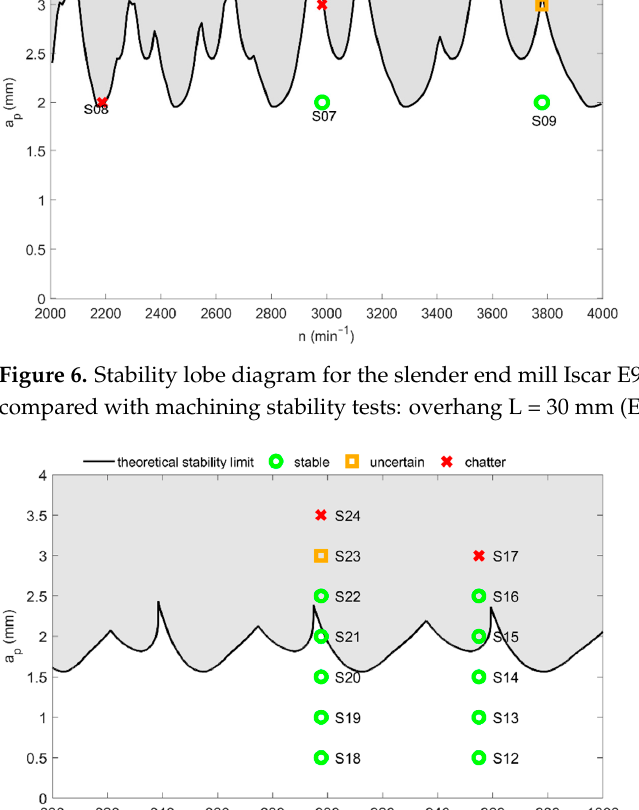
Figure 7. Stability lobe diagram for the rigid shoulder mill Walter F4042 based on measured FRF and compared with machining stability tests (Experiment 3).